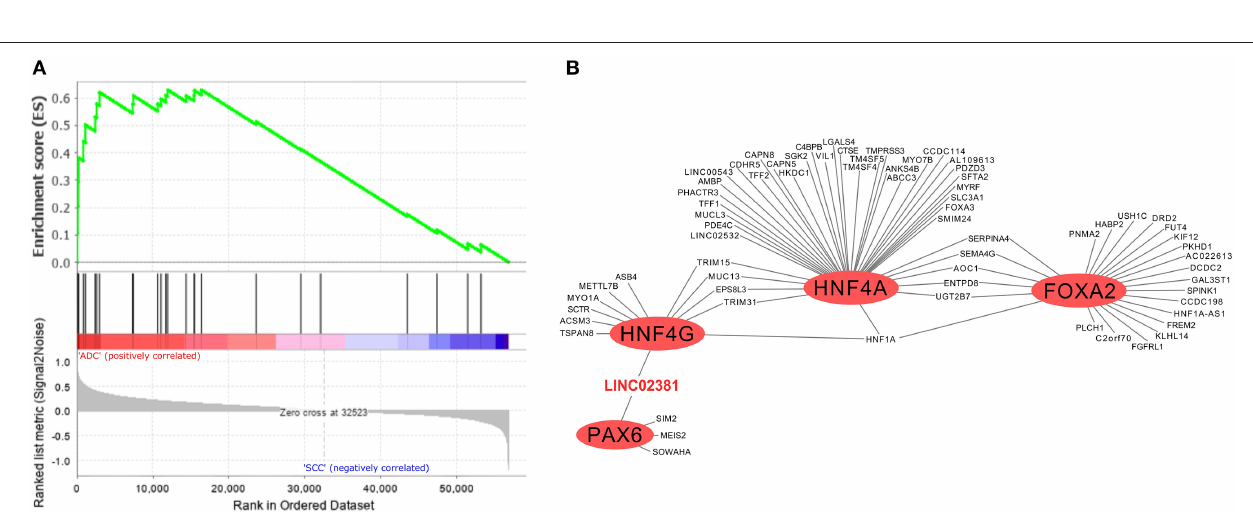
FIGURE 4 | Gene set enrichment analysis and transcriptional regulatory network (TRN) of upregulated genes in cervical adenocarcinoma (ADC) samples from our study. (A) Fourteen genes enriched in ADC that participate in maturity-onset diabetes of the young (MODY) pathway were not expressed neither in SCC nor in non-tumoral cervical tissue and HPV-negative (non-CC) tissue samples, calculated by GSEA software (12). (B) Among transcription factors (TF) related to MODY pathway, hepatocyte nuclear factor 4 ( HNF4G/A ), pancreatic and duodenal homeobox 1 ( PDX1 ), and forkhead box protein A2 ( FOXA2 ) (red circles) are related to expression of several upregulated genes in ADC samples in TRN analysis, including protein-coding genes and of LINC02381 long non-coding RNA (lncRNA) gene (in red).